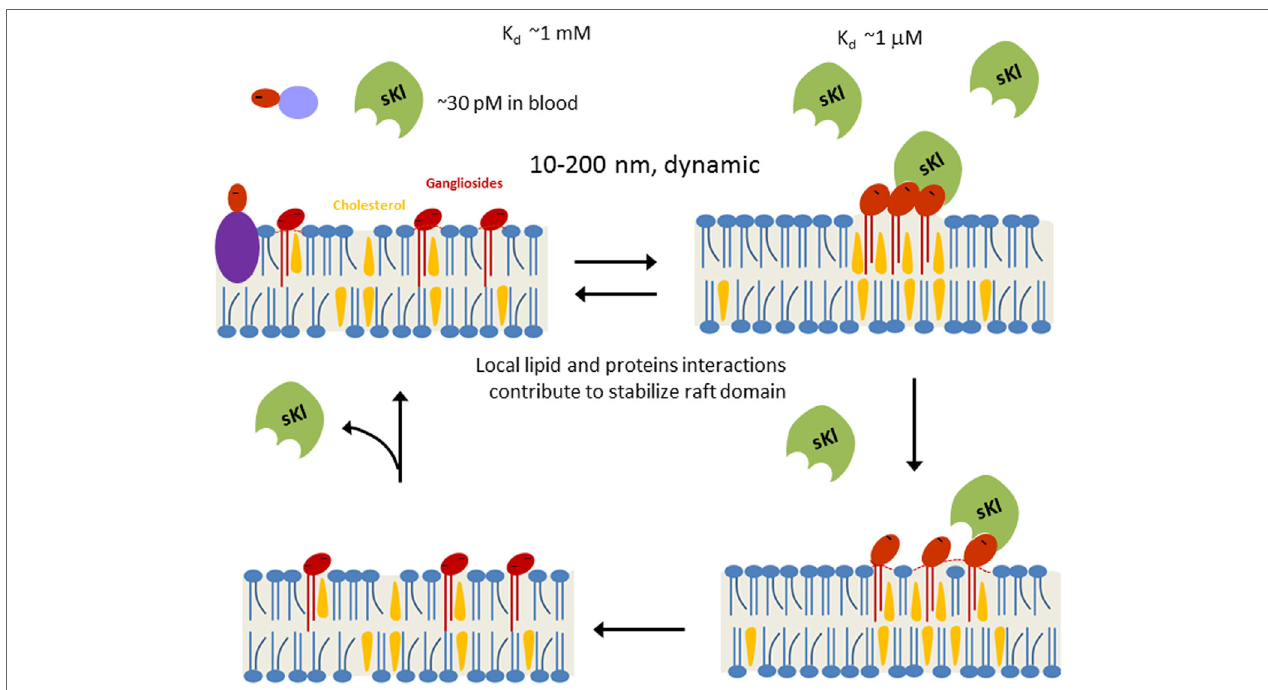
FiGURe 1 | Working model for soluble klotho (sKl) regulation of lipid rafts. Lipid rafts are highly dynamic cholesterol- and sphingolipid-rich membrane microdomains (10–200 nm in size). Formation of lipid rafts is governed by physicochemical properties of lipids and stabilized by local lipid–protein and protein–protein interactions. α 2,3-Sialyllactose (dark-red ovale) is a common glycan motif present in many secreted glycoproteins, membrane glycoproteins, and glycolipids such as gangliosides. Due to low circulating concentration (~30 pM) and low binding affinity ( K d ~1 mM), sKl does not bind to isolated α 2,3-sialyllactose significantly. Clustering of α 2,3-sialyllactose-containing gangliosides in lipid rafts enhances the “apparent” binding affinity for the likely multivalent sKl. Binding of sKl to gangliosides decreases the formation of rafts. sKl is likely multivalent for binding sialyllactose because each sKl contains homologous KL1 and KL2 domains and it likely exists as dimers